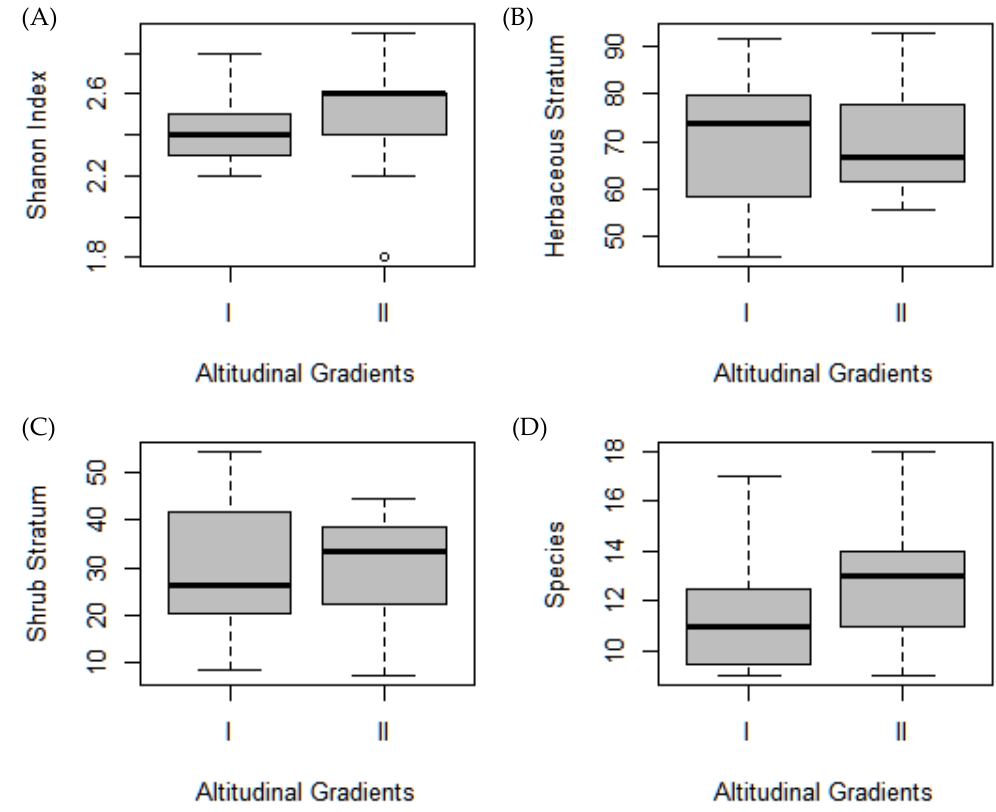
Figure 3. Boxplot of some structural and richness characteristics in each altitudinal gradient. Hereby ( A ) represents the Shanon index; ( B ) the herbaceous stratum; ( C ) the shrub stratum; and ( D ) total species.